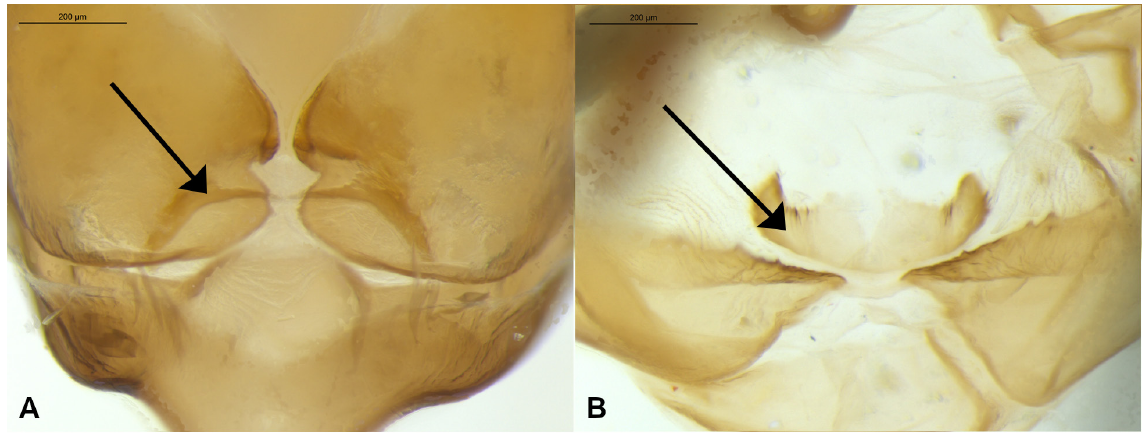
Fig. 8. Fultura inferior (i.e., juxta). A . Zischkaia pacarus (Godart, [1824]) (DZ 5. 578), in ventral view. B . Z. saundersii (Butler, 1867) (DZ 5. 580), in posterior